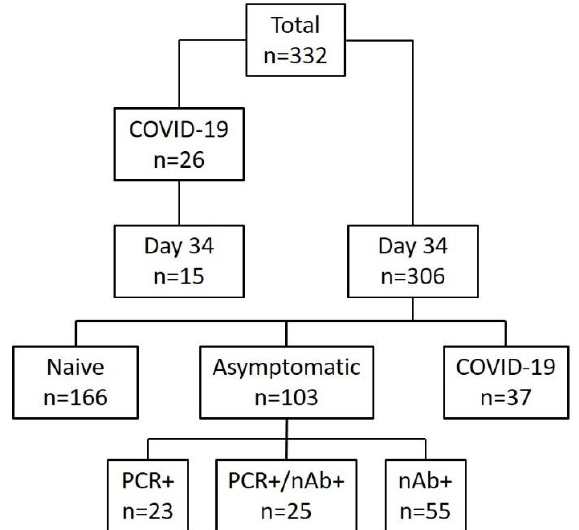
Figure 1. Schematic overview of the study. A total of 332 individuals participated: 306 in the cross-sectional part (one single sampling on 14 April 2020) and 26 patients suffering from non-severe COVID-19 in the longitudinal part with daily sampling. Out of 306 participants, 37 (12%) had previously been diagnosed with COVID-19, 103 (32%) had evidence of asymptomatic infection and 166 had no evidence of infection by SARS-CoV-2. Of the 103 asymptomatically infected, 23 were solely positive by PCR but had no neutralizing antibodies (nAbs), 55 (53%) had solely nAbs but were PCR negative and 25 (24%) had both, a positive PCR and nAb.